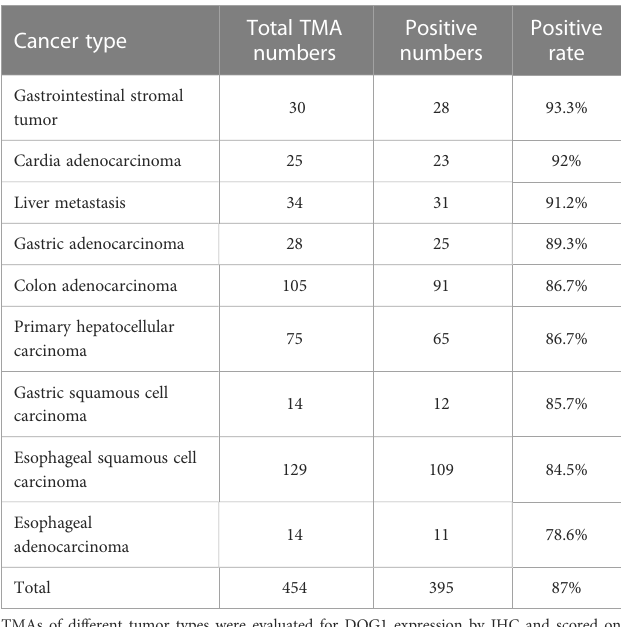
TMAs of different tumor types were evaluated for DOG1 expression by IHC and scored on a range of 0 to 3. An IHC score of ≥ 2 was chosen to identify tumors with positive DOG1